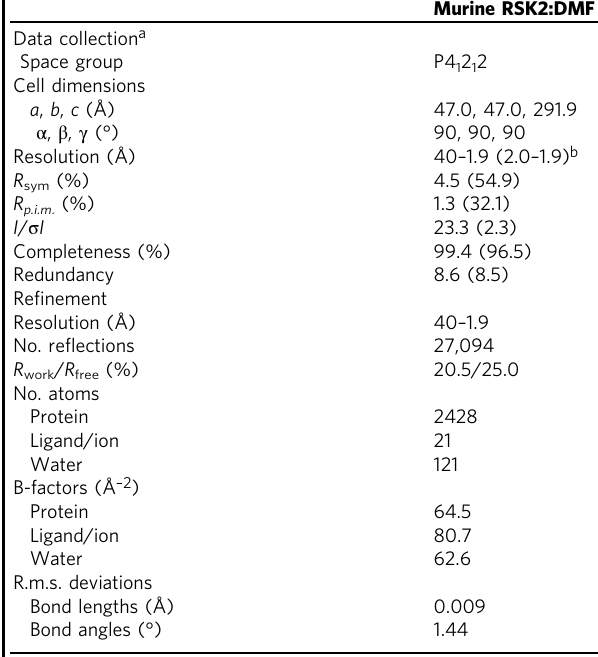
Table 2 Crystallographic data collection and re fi